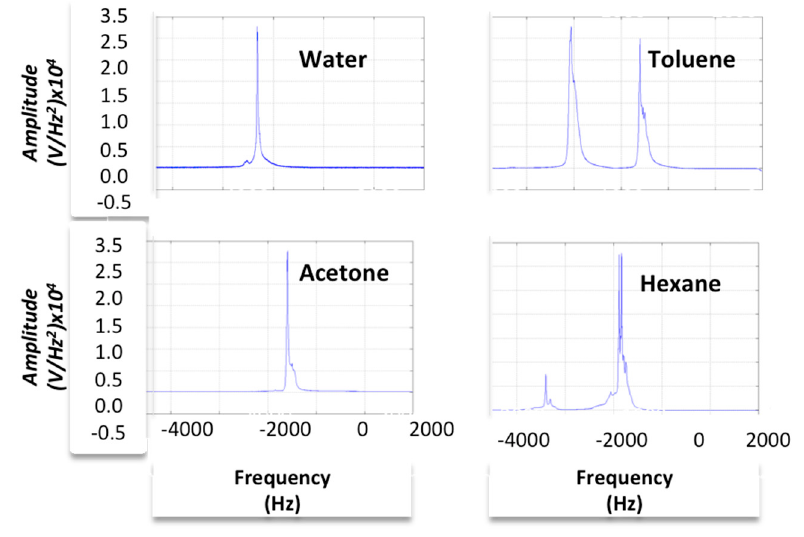
Figure 12. Mini-Coil Experimental results, Water, Toluene, Acetone and Hexane.